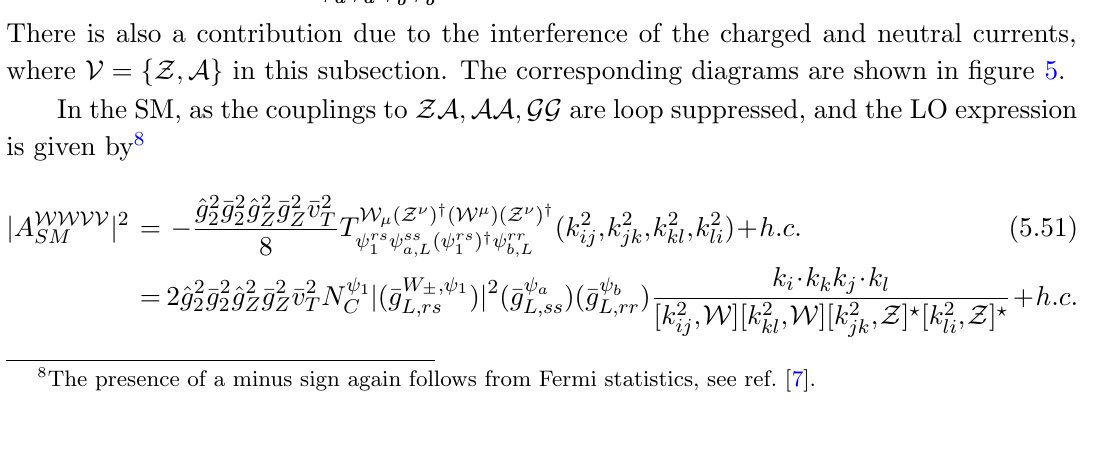
Figure 5 . Neutral-charged current interference contributions to h ! 4 . The SM diagrams also represent O ((cid:22) v 2 = (cid:3) 2 ) operator insertions perturbing the SM prediction with the same pole structure T as the